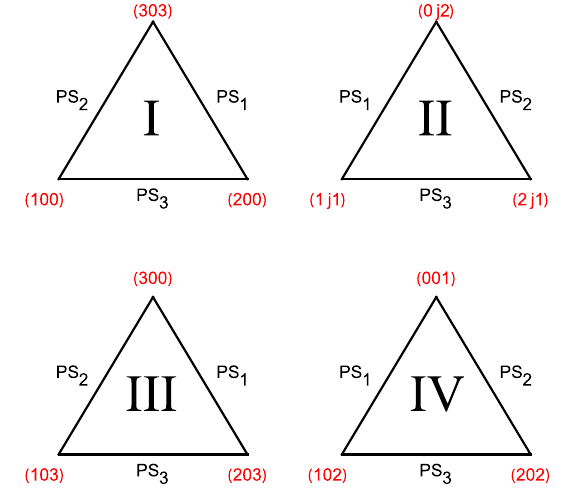
FIG. 11. Four sets of three mutually anticommuting fermionic σ τ bilinears, denoted by ð ikl Þ ≡ η , sitting at the vertices of i k l four triangles (see Table V). Each triangle demonstrates the SU(2) pseudospin rotation among (I) the charge density wave and two (real and imaginary) components of s -wave pairing; (II) the spin bond-density wave and two components (real and imaginary) of triplet pairing with a specific spin orientation ( j ¼ 1 , 2, 3); (III) the charge density and the components (real and imaginary) of chiral singlet pairing 2 ; and (IV) the x -charge current and the components (real and imaginary) of chiral singlet pairing 1 . The pseudospin generators (PS with j ¼ 1 , 2, 3) j [Eq. (38)] correspond to (III). Any arm of a triangle represents the rotation between two bilinears, sitting at two corresponding vertices, by a specific Table V), can also be established from the Clifford algebra of real matrices, as shown in Appendix G.